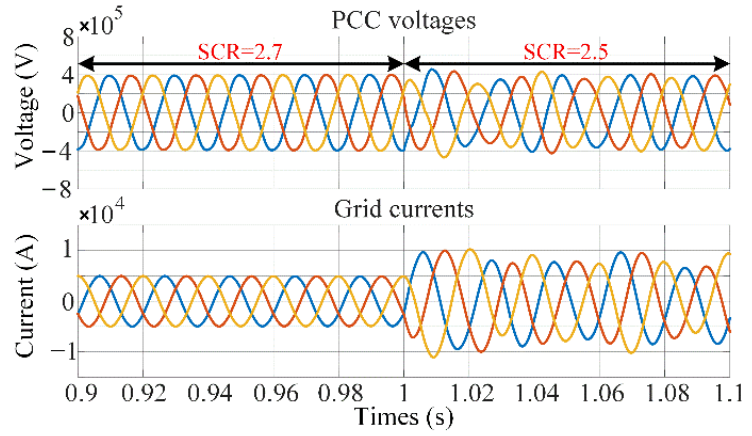
Figure 13. Simulation results of the grid-connected MMC with the phase current controller.